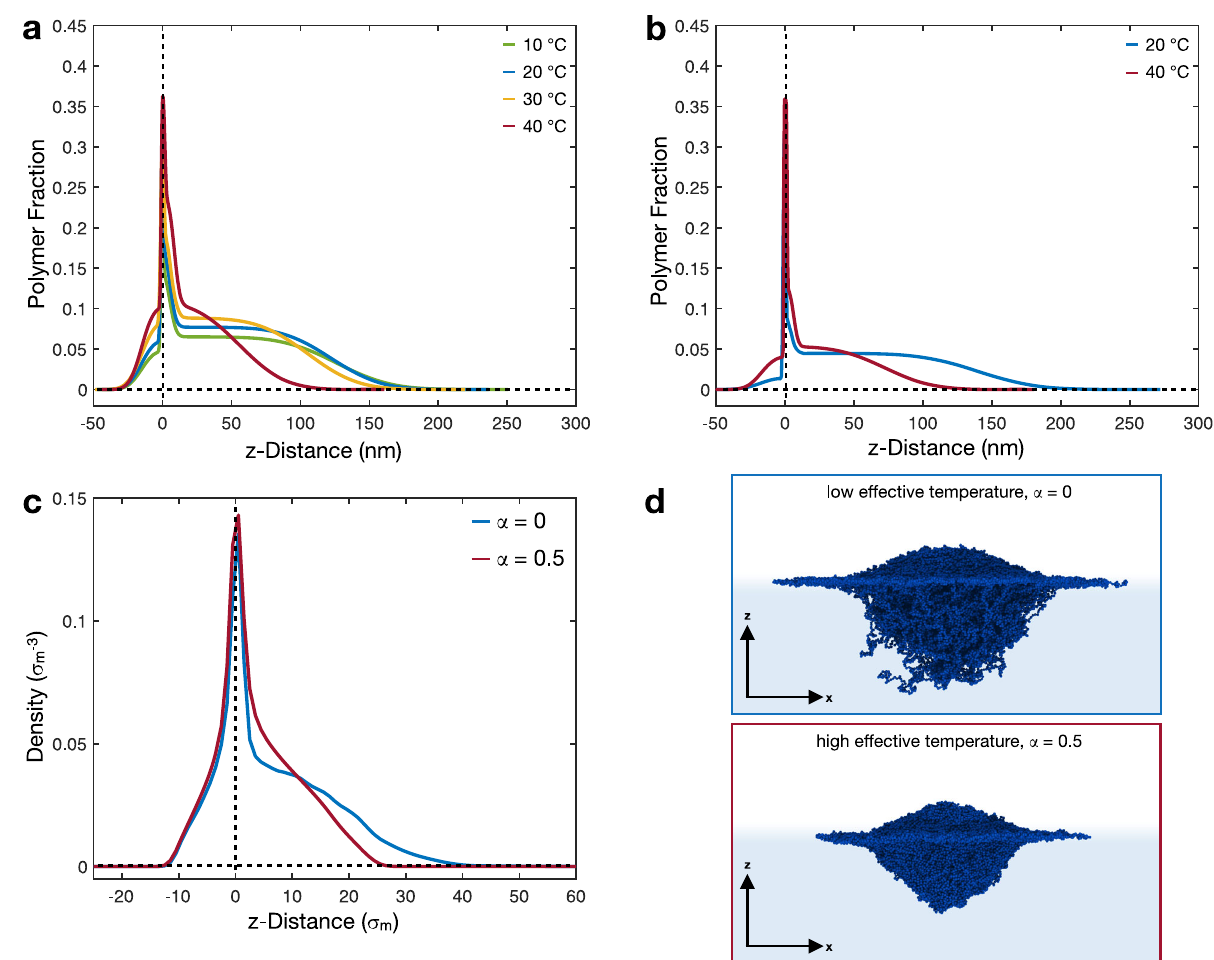
Fig. 2 Structure of 5 mol% cross-linked microgels at liquid interfaces. Polymer fractions of the adsorbed 5 mol% D0 ( a ) and 5 mol% D7 ( b ) microgels at different temperatures. c Density pro fi les of simulated microgels at different effective temperatures, corresponding to α = 0, 0.5. Horizontal and vertical dashed lines are guides to the eyes and represent zero polymer fraction/density and zero z-distance from the interface, respectively. Negative values of z represent the air phase and positive values represent the water phase. d Simulation snapshots showing the side perspective of an adsorbed standard microgel for α = 0, and 0.5. Solvent particles are not shown for visual clarity.